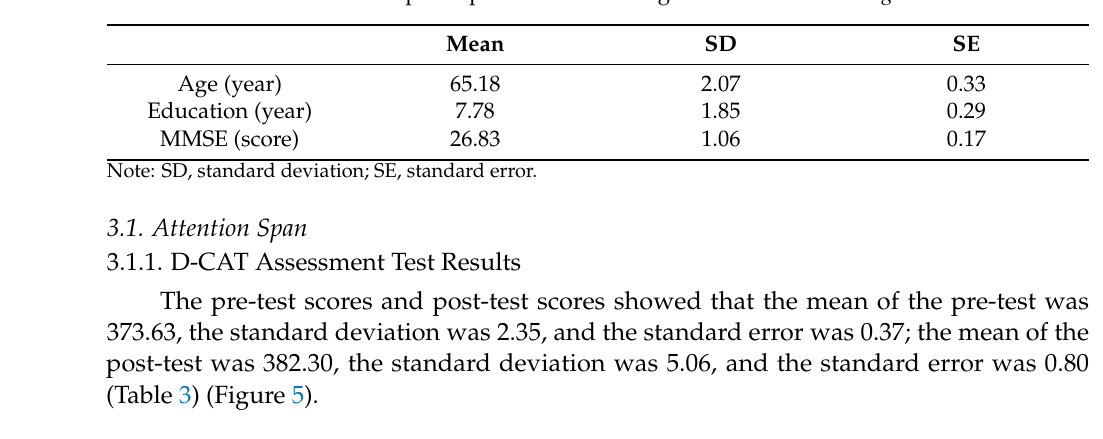
Table 3. Paired samples statistics of D-CAT.